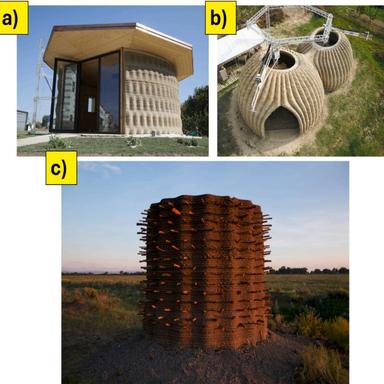
3DP of earthen material-based house projects (a) Gaia, (b) TECLA, and (c) Mud frontiers.